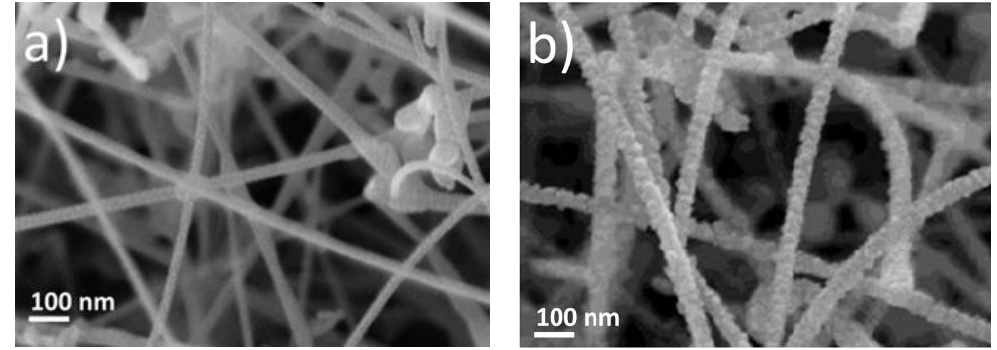
Figure 1. Scanning electron microscopy (SEM) pictures of SnO 2 nanowire sensors ( a ) before and ( b ) after 1000 s of Hexamethyldisiloxane (HMDS) passivation.